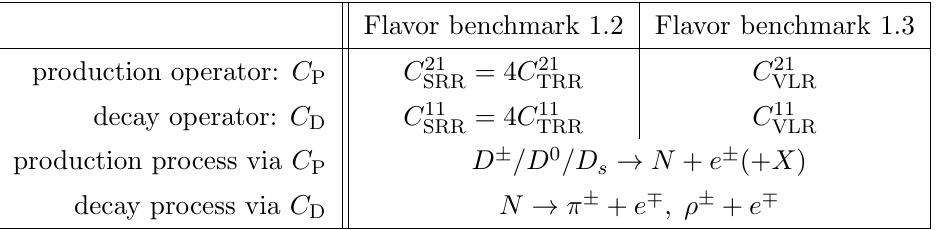
Table 3 . Summary of (cid:13)avor benchmark 1 for the theoretical scenarios 2 and 3 of section 5, respectively. X denotes any additional (cid:12)nal state particles.